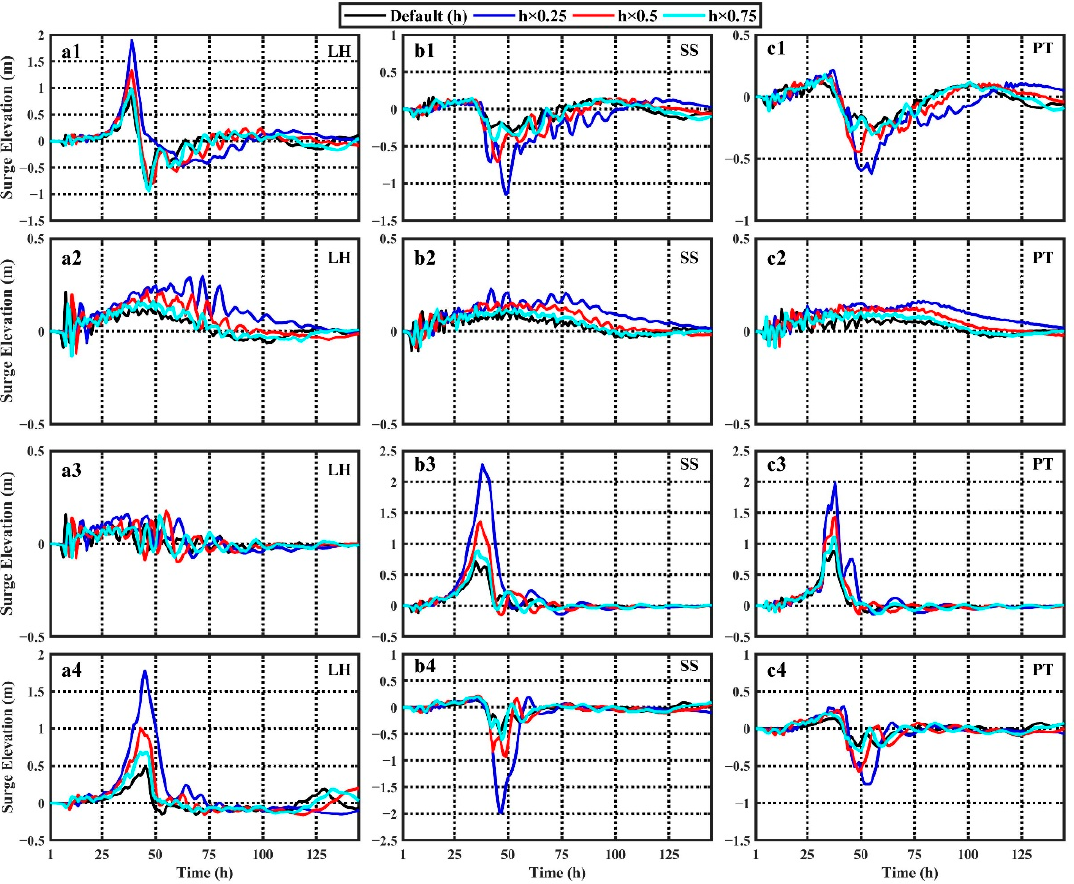
Figure 21. The time series of surge elevations in cases with different topography settings: ( a1 – c1 ) Chan-hom, ( a2 – c2 ) Mireille, ( a3 – c3 ) Herb, and ( a4 – c4 ) Winnie. Table 9. The model results of surge, fall, time and the value of AI in sensitivity experiments with different topography at three stations (LH, SS, and PT). Surge (m): Surge max ; fall (m): Fall max ; time: occurrence time of surge reaches the peak (from a cold start); AI: asymmetry index.